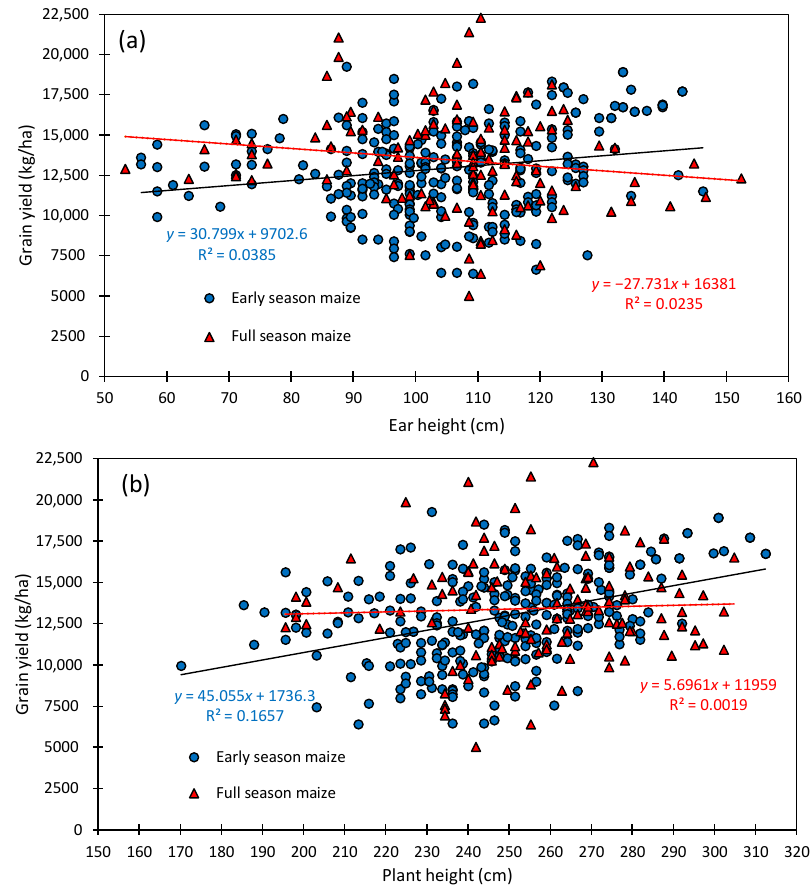
Figure 8. Relationships between maize grain yield and ( a ) ear height and ( b ) plant height.